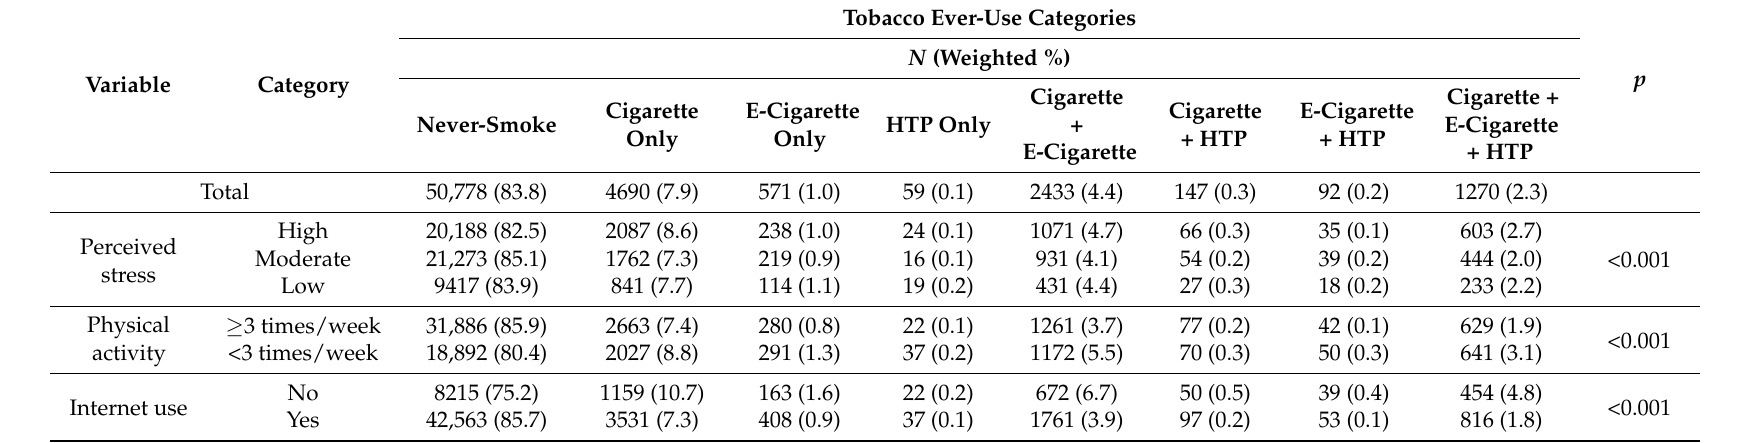
Table 2. Perceived stress, physical activity, and internet use according to tobacco ever-use categories.